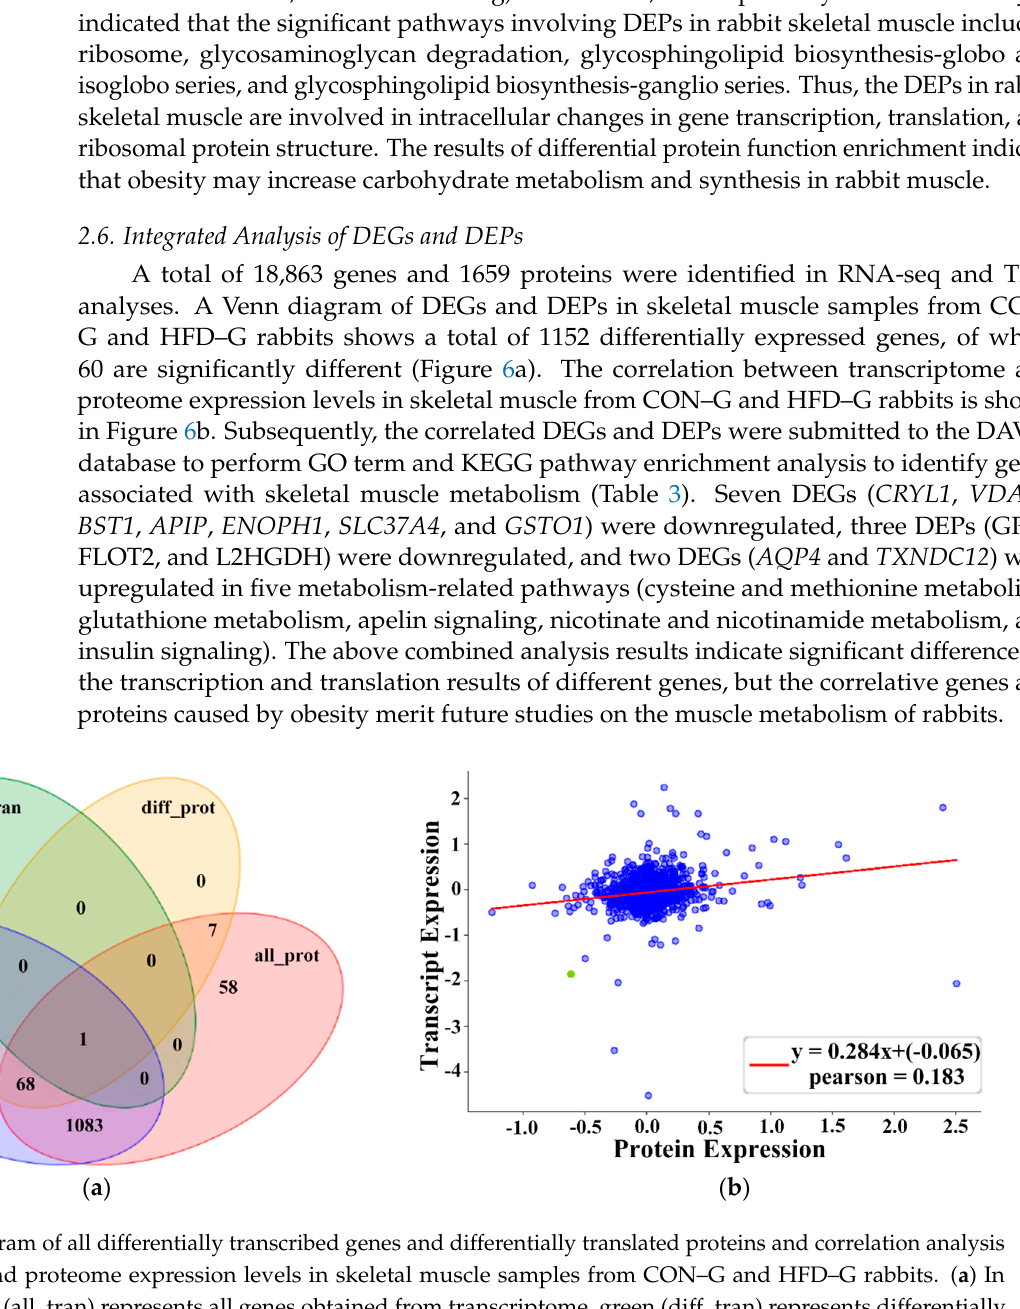
Figure 5. Screening and functional enrichment analysis of GO functions and KEGG signaling pathways of differentially expressed proteins in skeletal muscle samples from CON–G and HFD–G rabbits. ( a ) Colors in volcano map represent downregulated proteins (green dots), upregulated proteins (red dots), and nonsignificant proteins (black dots). ( b ) Colors in the heatmap represent changes in protein levels, from high (red) to low (blue). Left brackets represent clustering rela- tionships among genes, and top brackets represent clustering relationships among samples. ( c ) In GO functional enrich- ment diagram, three colors represent biological processes (BP), cellular components (CC), and molecular functions (MF). Height of each column represents number of enriched genes. ( d ) In KEGG pathway enrichment diagram, color ranges from red (significant) to blue (nonsignificant), and circle size indicates number of enriched genes.